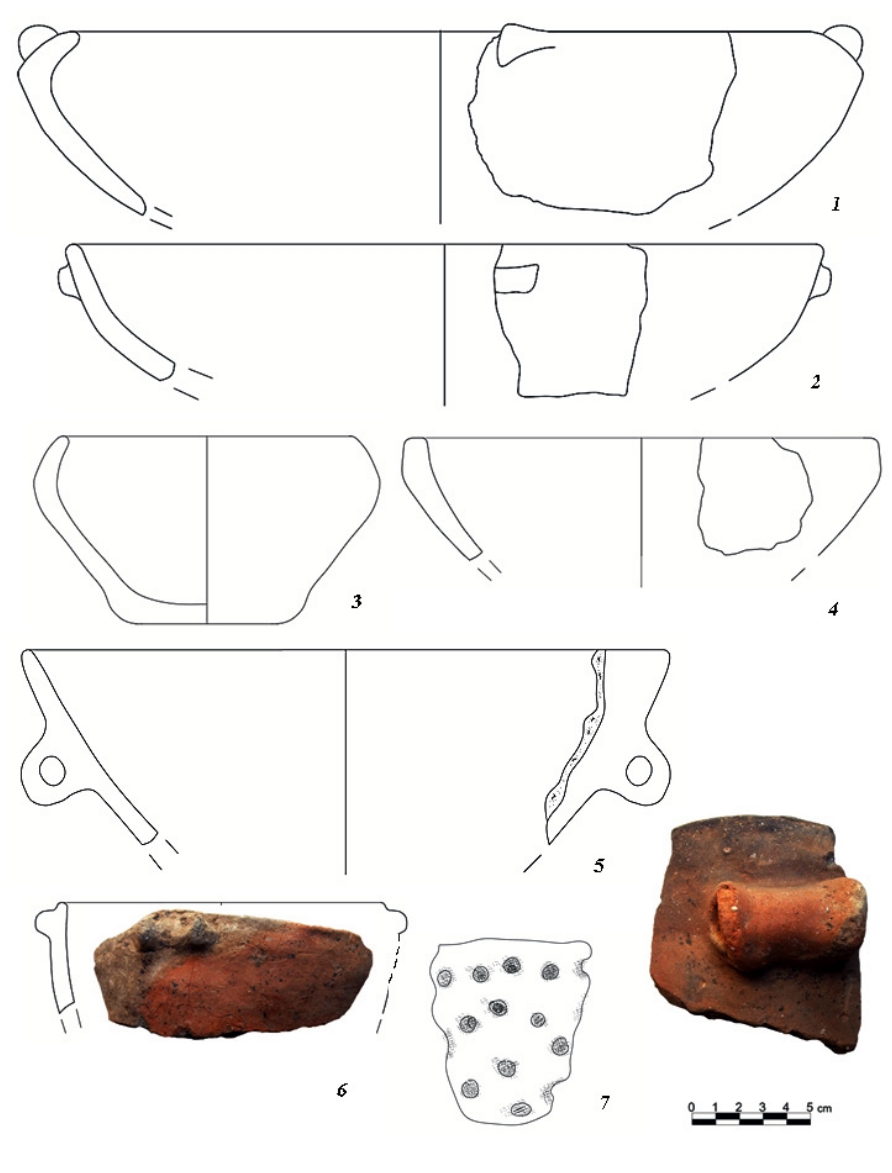
Figure 4. S. Martino. Diana pottery. Bowls and cups with typical